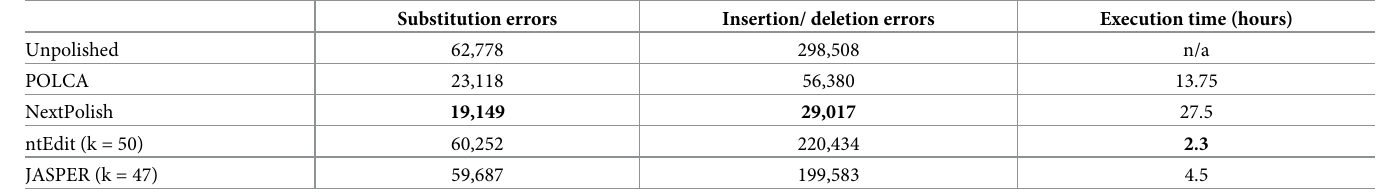
Table 3. Comparison of the polishers on the human CHM13 assembly polished with Illumina reads. Timing data used a 24-core Intel Xeon Gold 6248R @ 3.0Ghz server with 24 threads. JASPER and ntEdit are the two fastest polishers. JASPER is slower than ntEdit, but it produces more accurate polished